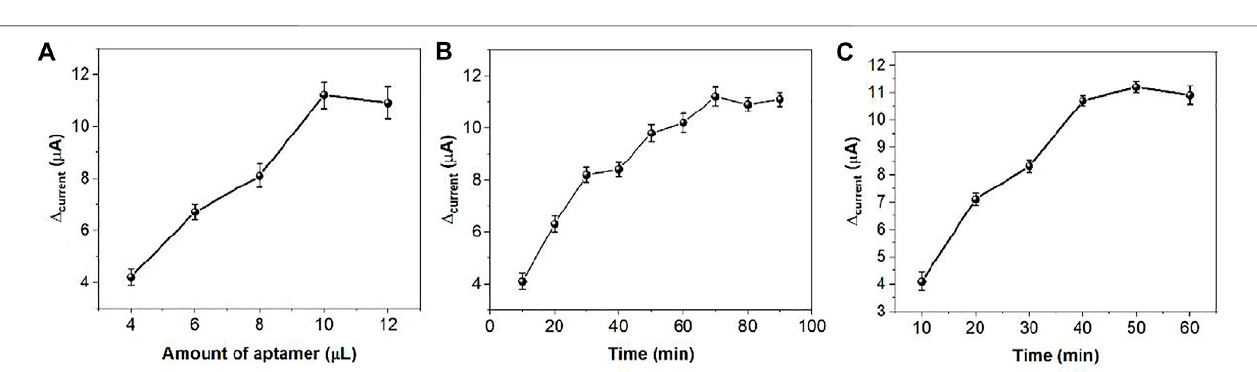
Frontiers in Chemistry |